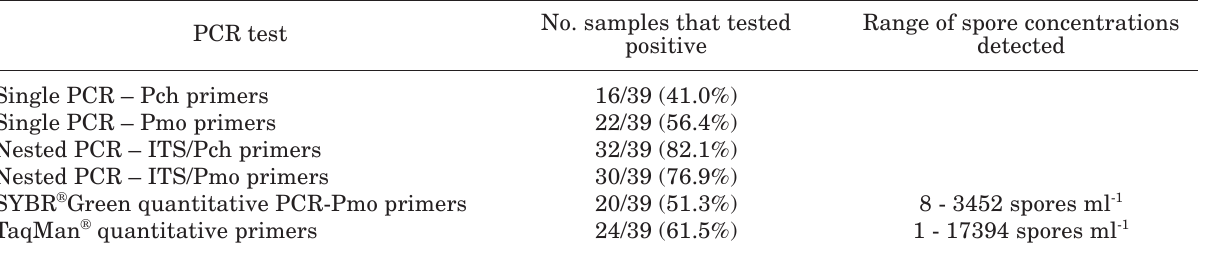
Table 4. Comparison of PCR tests used for detection of P. chlamydospora in 2005 grapevine nursery water